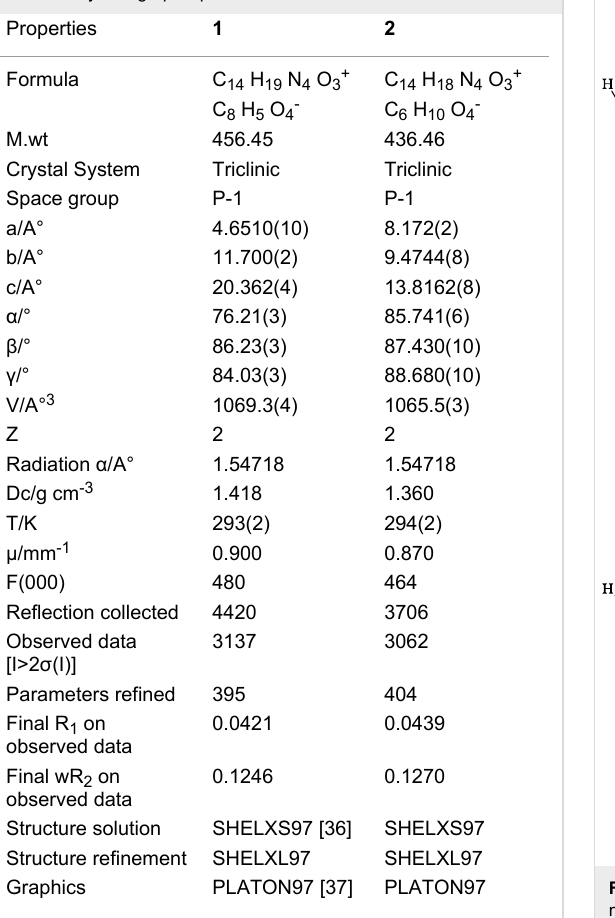
Table 1: Crystallographic parameters for 1 and 2 Properties